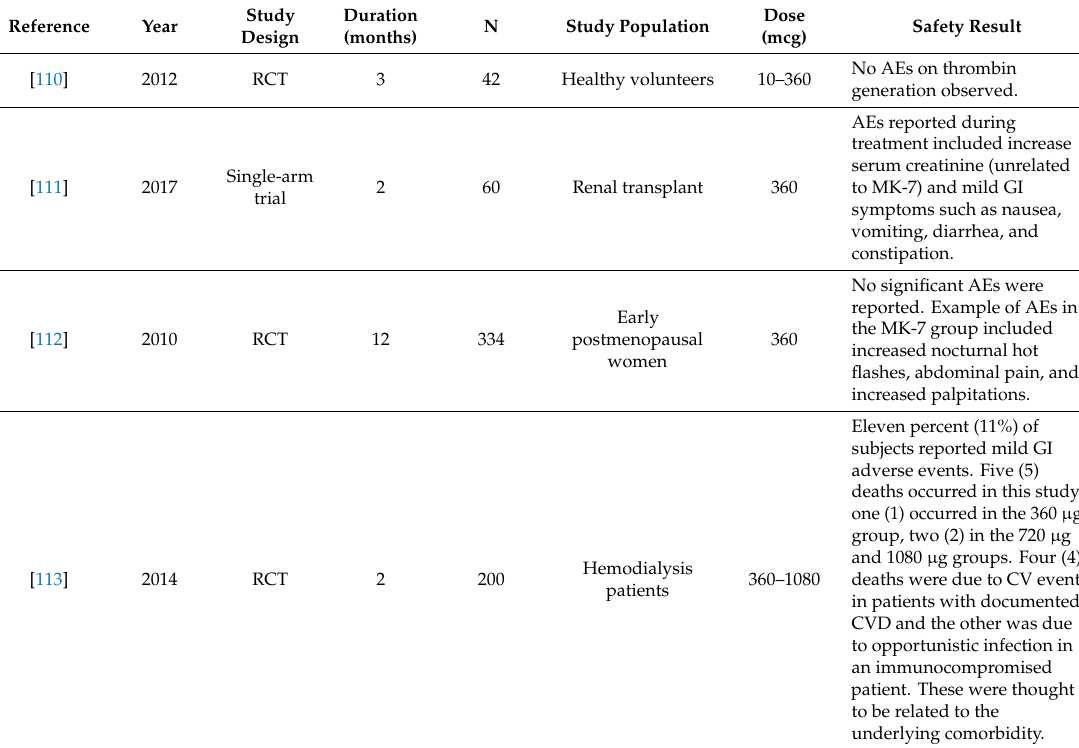
Table 4. Summary of Safety Profile of